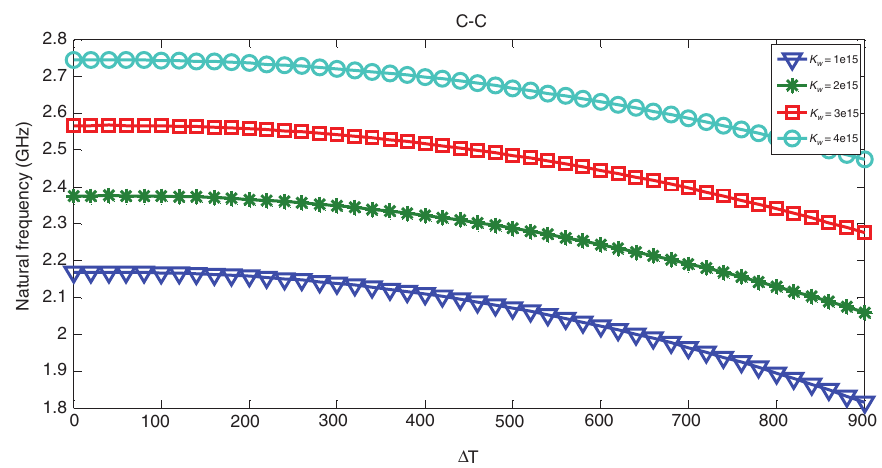
Figure 5: The effect of Winkler stiffness on natural frequency with clamped-clamped boundary condition.